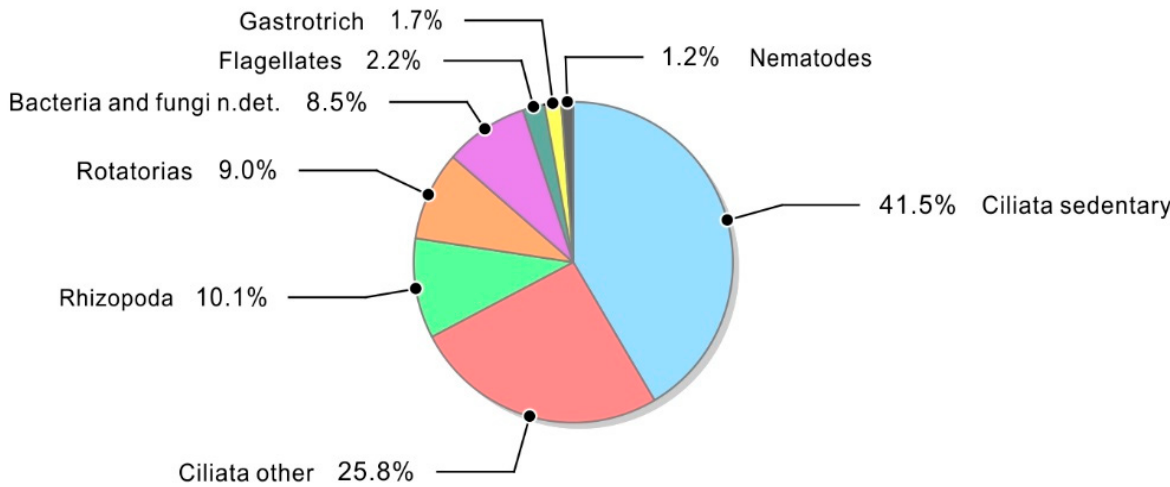
Figure 8. Average percentage of taxa in the activated sludge from the aeration chamber.